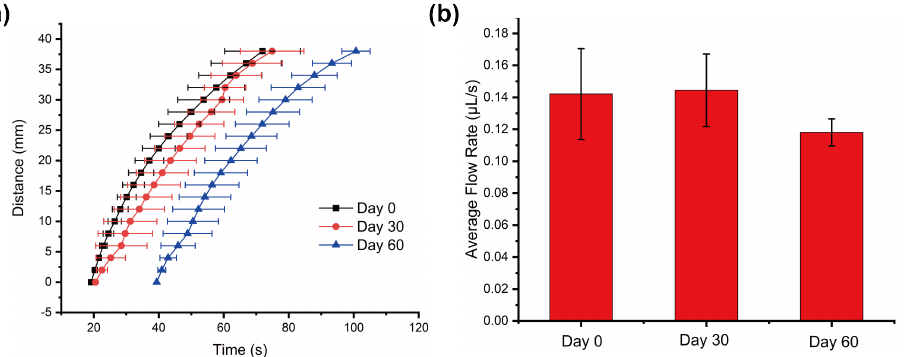
Figure A5. Flow behavior of whole blood samples on devices with shelf life of 0 day, 30 days, and 60 days. ( a ) A comparison of the distance-time curves and ( b ) a comparison of the average flow rates of plasma.